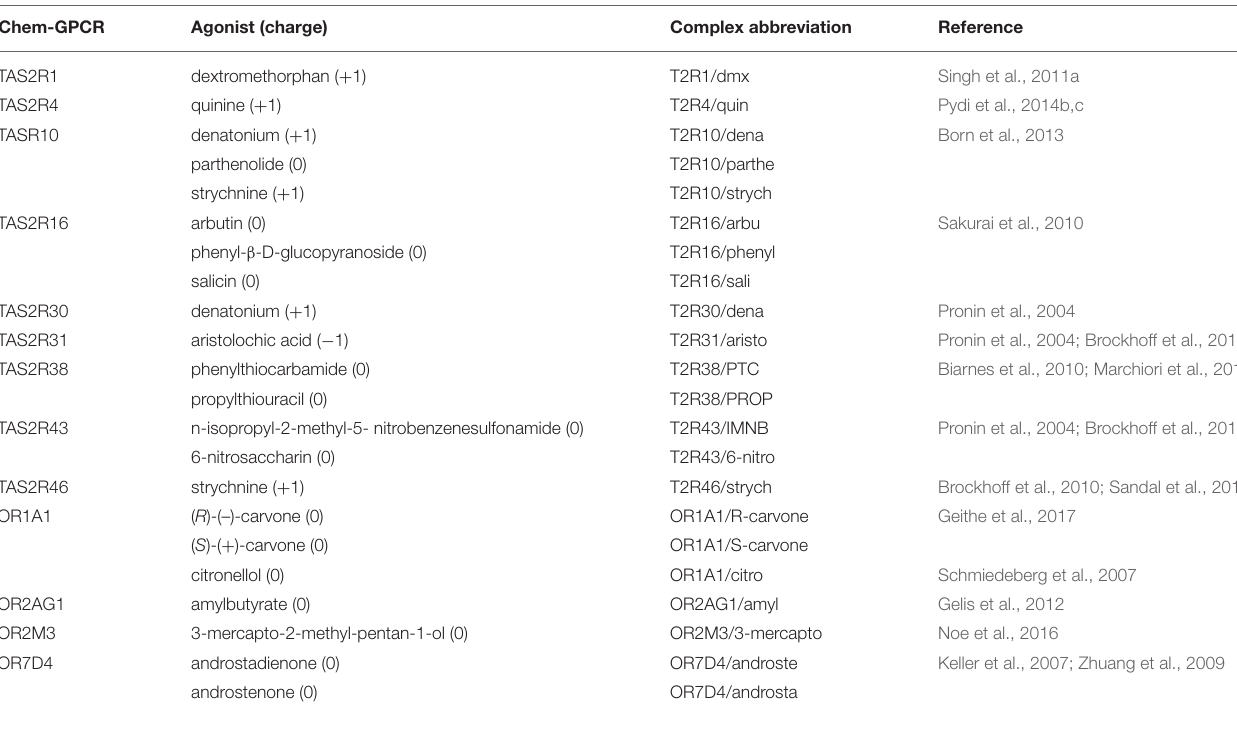
TABLE 2 | Human chemosensory GPCRs (hChem-GPCRs)/agonist complexes for which experimental data are available.